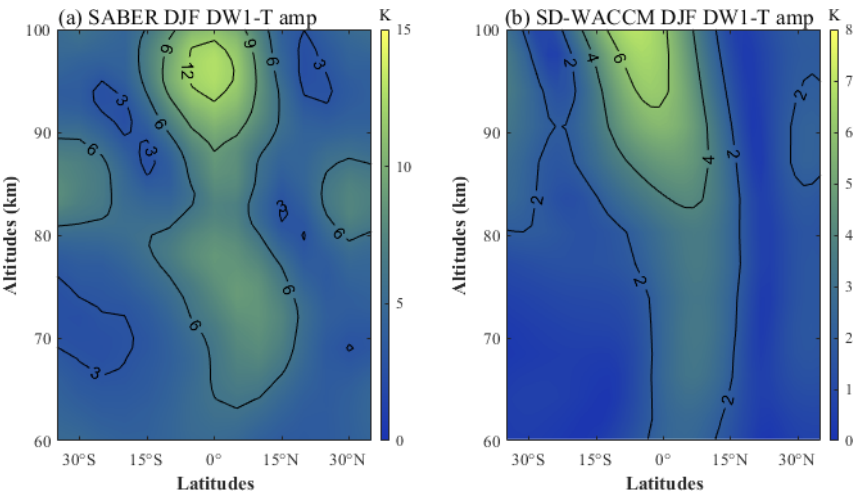
Figure 1. (a) The average DW1 temperature amplitude of SABER observation during the 2002–2013 winter (DJF, Dec–Jan–Feb). (b) The same as (a) , but for SD-WACCM.